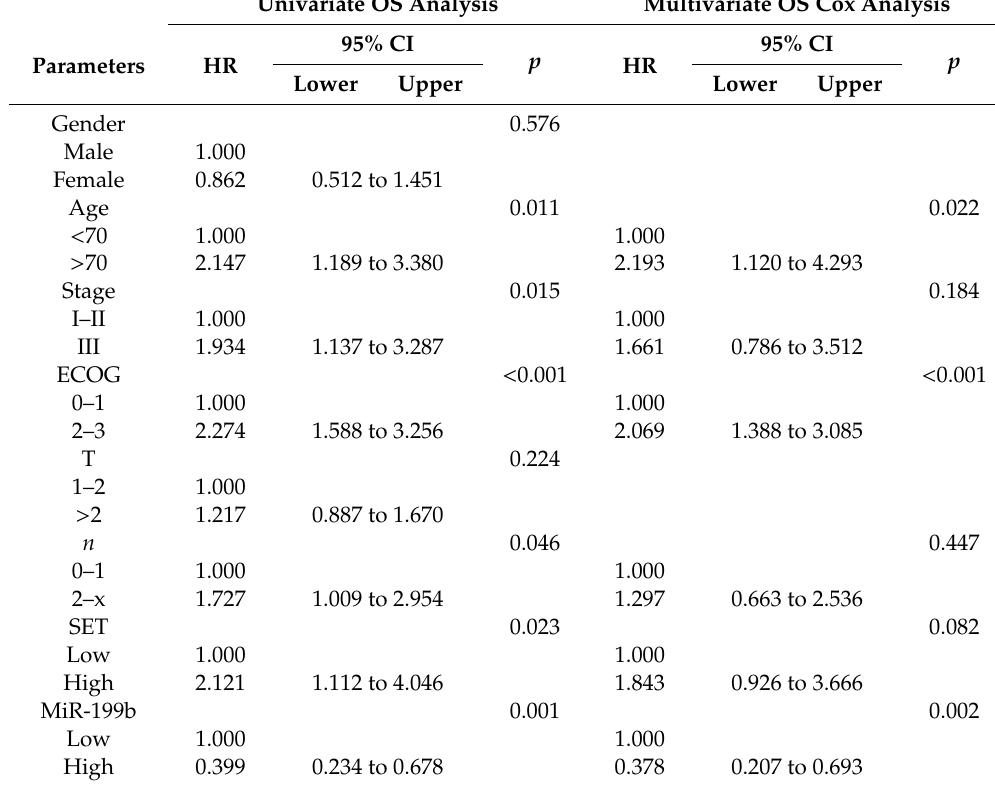
Table 3. Univariate and multivariate Cox analyses in the cohort of 157 patients with early-stage CRC. Univariate OS